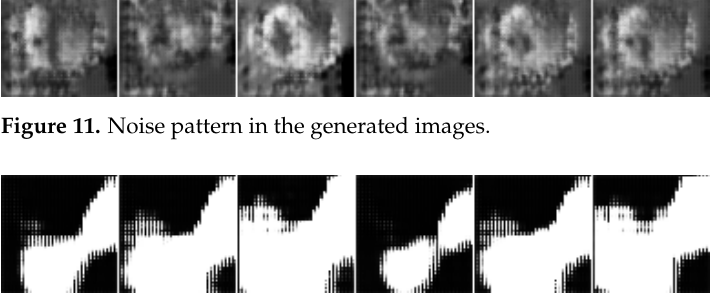
Figure 12. Generated images without object and shadow visible.